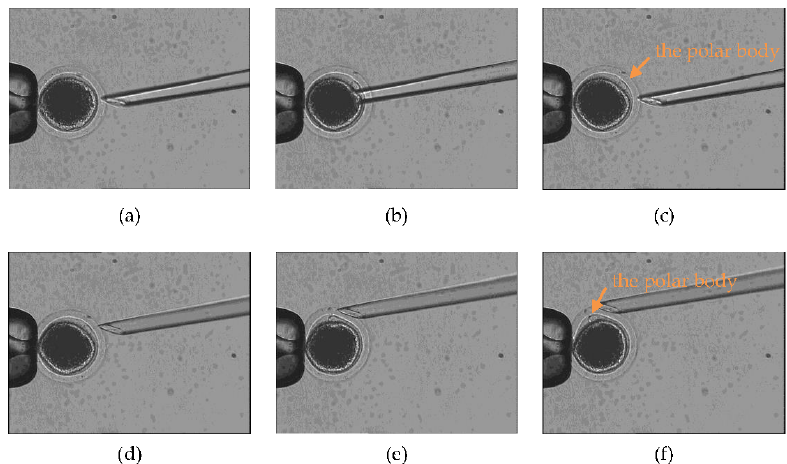
Figure 9. Experiment on nonoptimal poking direction. ( a – c ) The process of revolving (first stage). ( d – f ) The process of rotation when the polar body is in the focal zone (second stage). The injection micropipette is not parallel to the X axis.